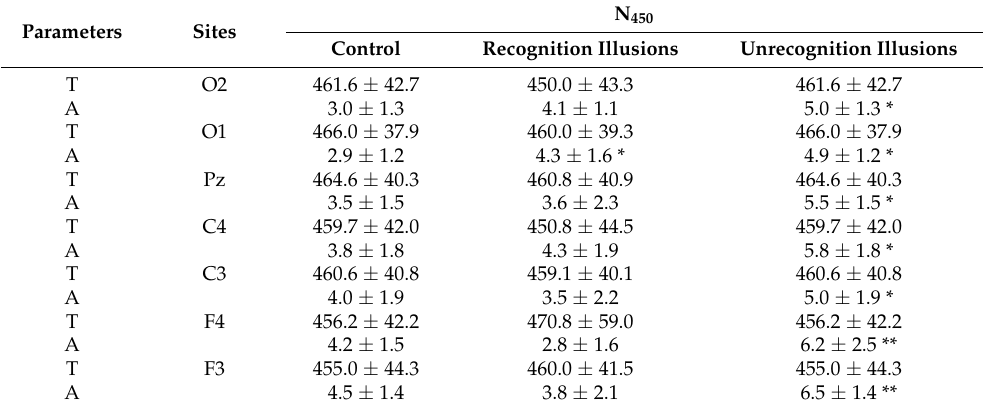
Table 4. Amplitude (A, uV) and time (T, ms) characteristics of the component N 450 ERP. Parameters Sites